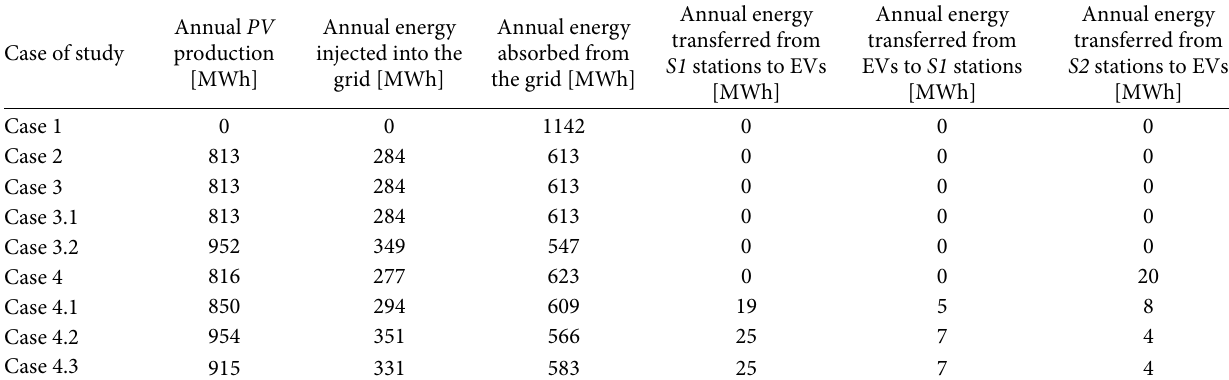
Table 3: Optimal energy